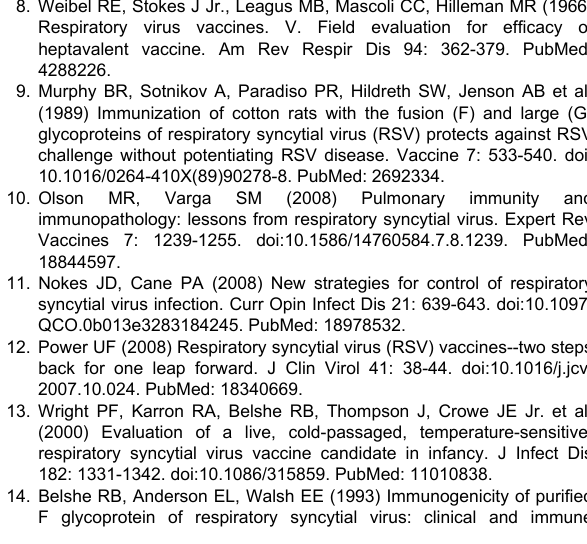
Figure S1. Antibody responses elicited by vaccination with RSV G protein nanoparticles and RSV G polypeptides. Groups of BALB/c mice (n=5) were vaccinated with polypeptides, polypeptides combined with alum, or nanoparticle